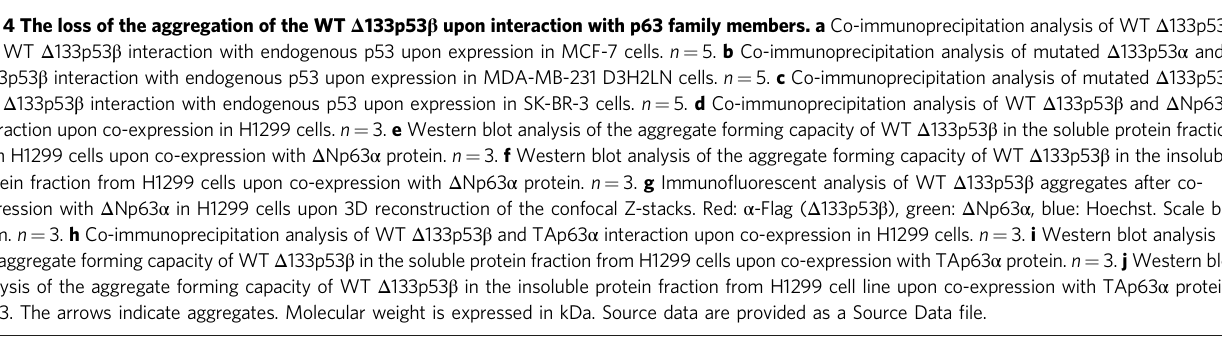
Fig. 4 The loss of the aggregation of the WT Δ 133p53 β upon interaction with p63 family members. a Co-immunoprecipitation analysis of WT Δ 133p53 α and WT Δ 133p53 β interaction with endogenous p53 upon expression in MCF-7 cells. n = 5. b Co-immunoprecipitation analysis of mutated Δ 133p53 α and Δ 133p53 β interaction with endogenous p53 upon expression in MDA-MB-231 D3H2LN cells. n = 5. c Co-immunoprecipitation analysis of mutated Δ 133p53 α and Δ 133p53 β interaction with endogenous p53 upon expression in SK-BR-3 cells. n = 5. d Co-immunoprecipitation analysis of WT Δ 133p53 β and Δ Np63 α interaction upon co-expression in H1299 cells. n = 3. e Western blot analysis of the aggregate forming capacity of WT Δ 133p53 β in the soluble protein fraction from H1299 cells upon co-expression with Δ Np63 α protein. n = 3. f Western blot analysis of the aggregate forming capacity of WT Δ 133p53 β in the insoluble protein fraction from H1299 cells upon co-expression with Δ Np63 α protein. n = 3. g Immuno fl uorescent analysis of WT Δ 133p53 β aggregates after co- expression with Δ Np63 α in H1299 cells upon 3D reconstruction of the confocal Z-stacks. Red: α -Flag ( Δ 133p53 β ), green: Δ Np63 α , blue: Hoechst. Scale bar the aggregate forming capacity of WT Δ 133p53 β in the soluble protein fraction from H1299 cells upon co-expression with TAp63 α protein. n = 3. j Western blot analysis of the aggregate forming capacity of WT Δ 133p53 β in the insoluble protein fraction from H1299 cell line upon co-expression with TAp63 α protein. n = 3. The arrows indicate aggregates. Molecular weight is expressed in kDa. Source data are provided as a Source Data